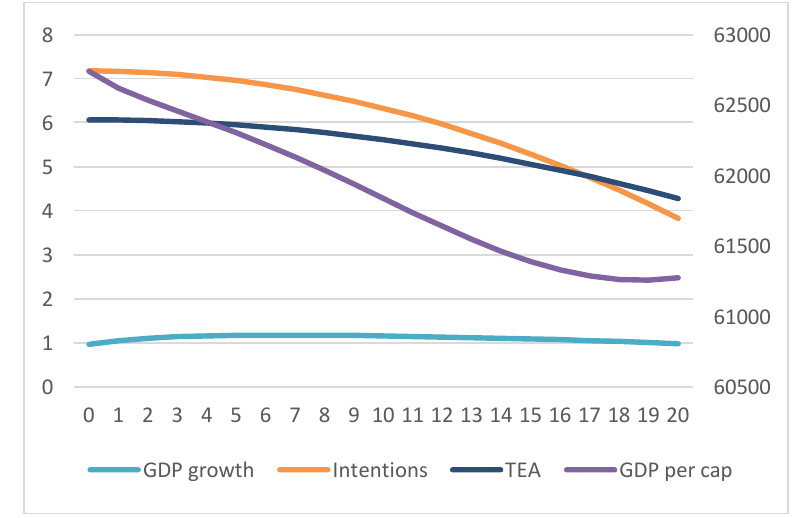
Fig. 5. The baseline model behaviour (Scenario 0)